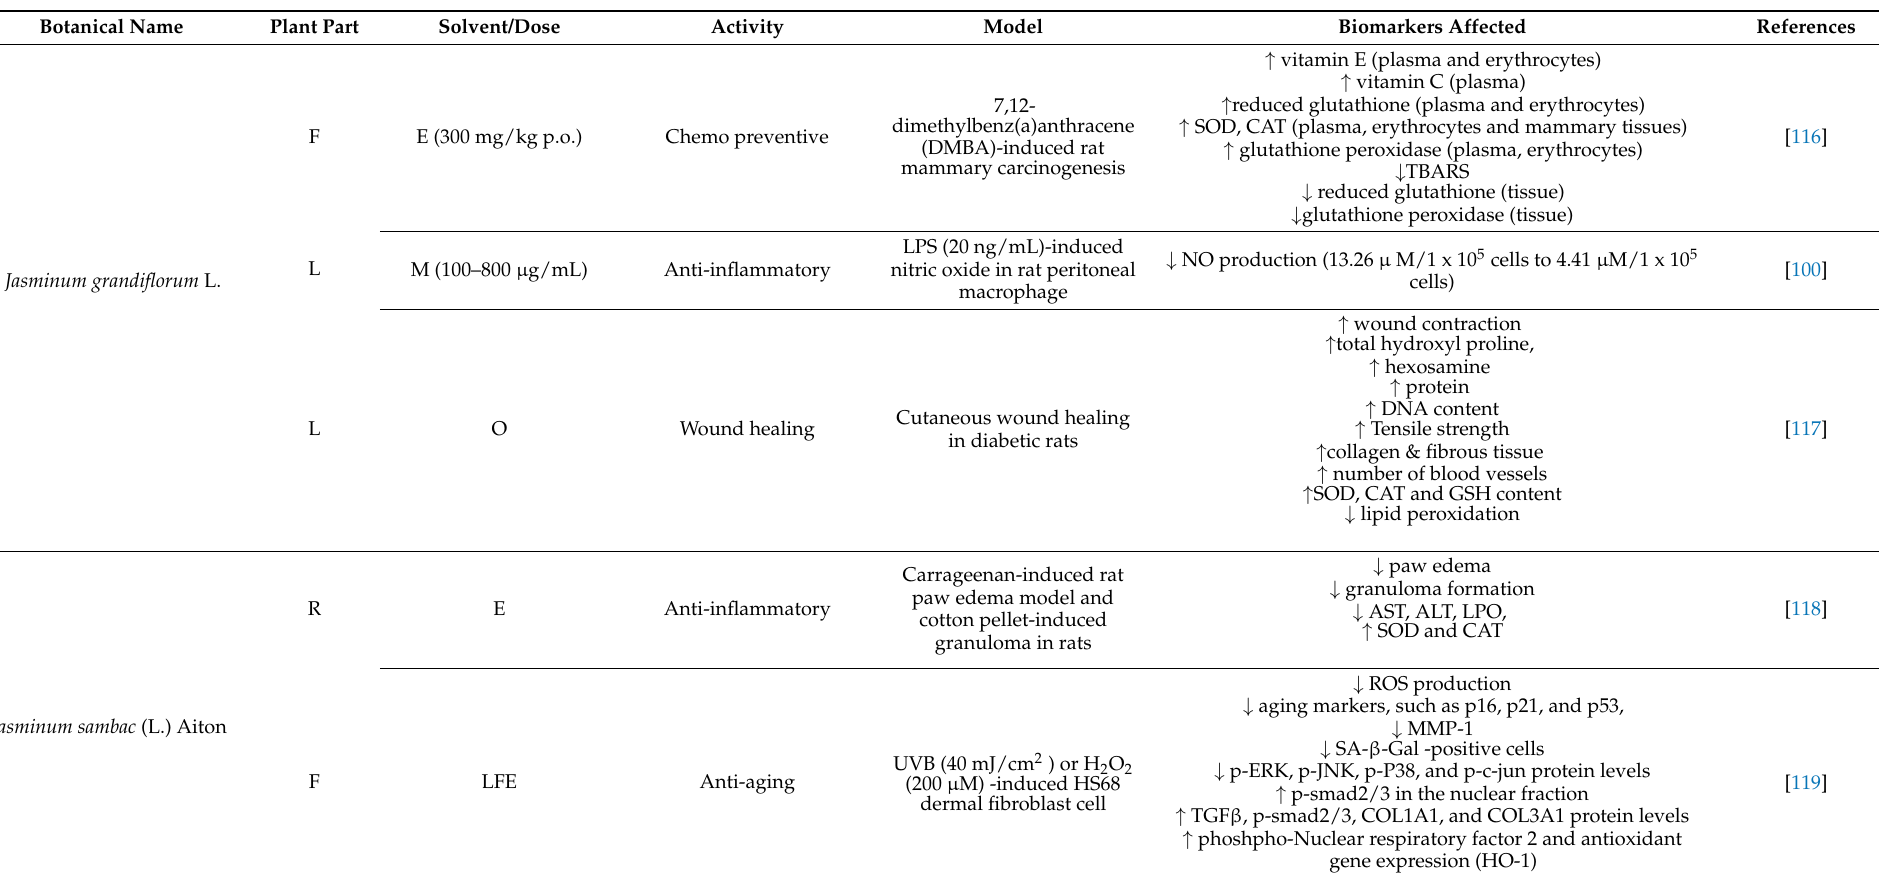
Table 3. Effect of Jasminum spp. against oxidative stress-related